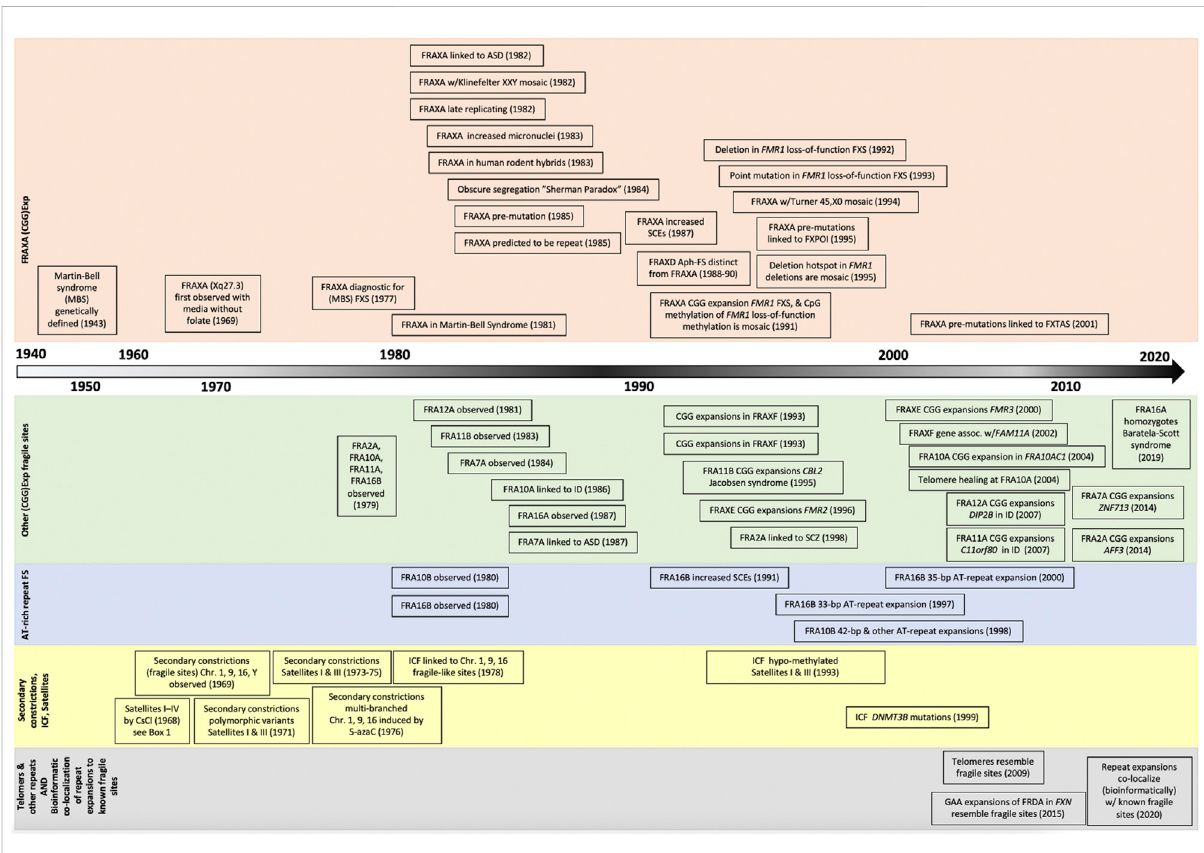
FIGURE 2 Timeline of discovery for tandem repeat expansions and chromosomal lesions. Increased awareness and improved methods of detection have fostered theidenti fi cation of dozens offragilesite inthe past two decades, with new bioinformatictechniques poised to launch an new era of fragile site